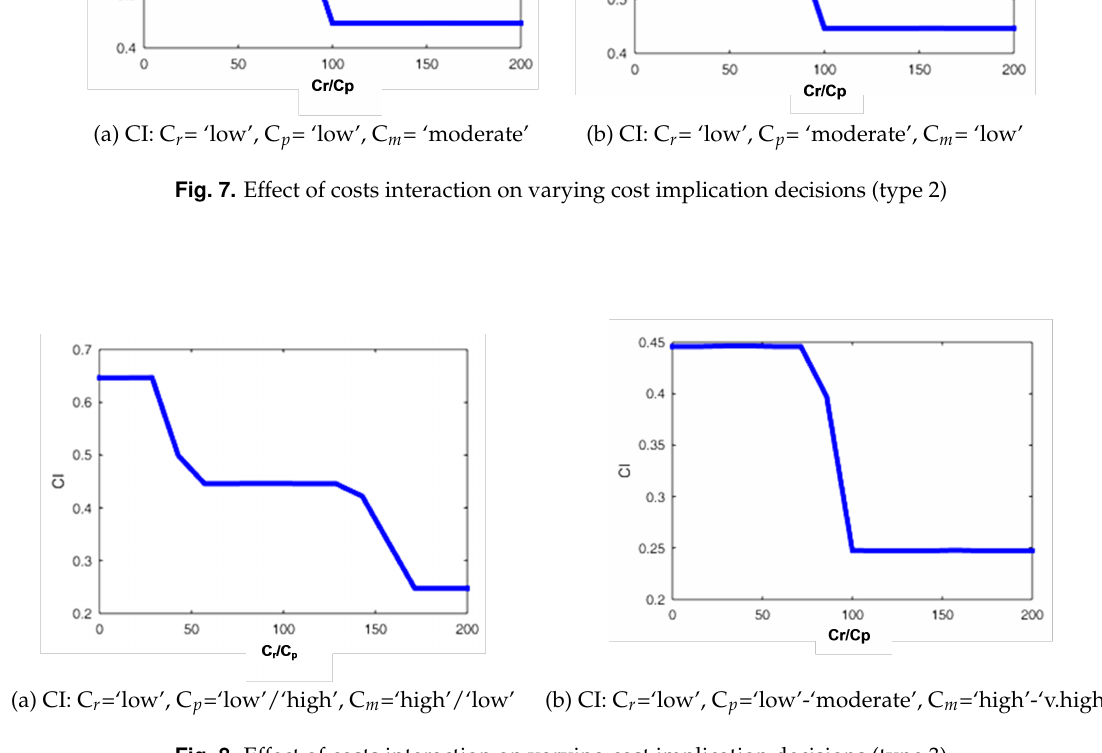
Fig. 8. Effect of costs interaction on varying cost implication decisions (type